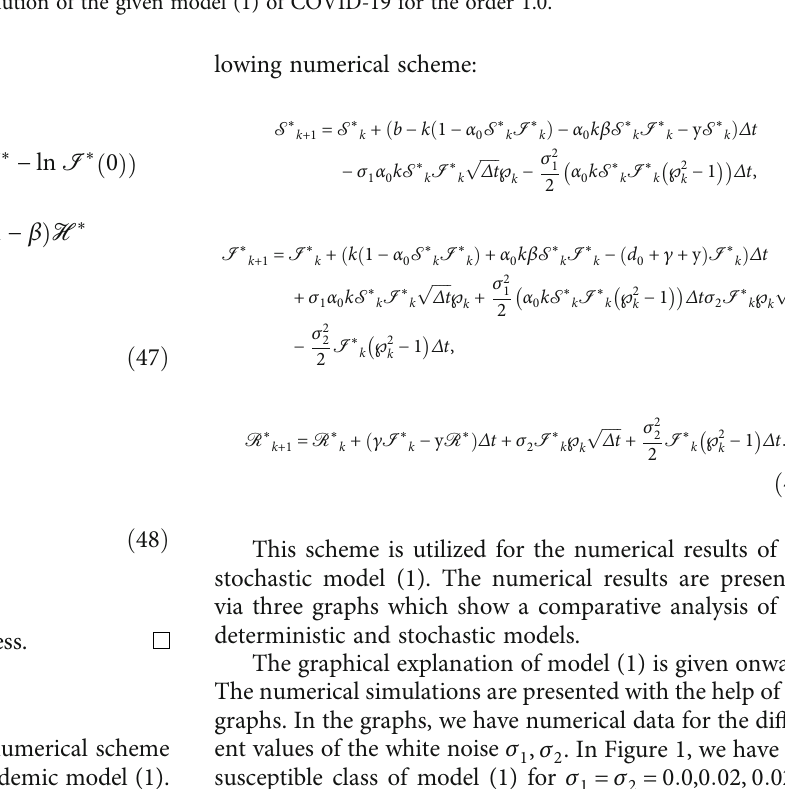
0 : 03 . Figure 2 represents numerical data for the infection rate in the model as per given initial and parametric values while varying the white noise for σ 0 : 03 . Figure 3 shows simulations for the recovered class of model (1), changing the white noise for σ 0 : 025, 0 : 03 .